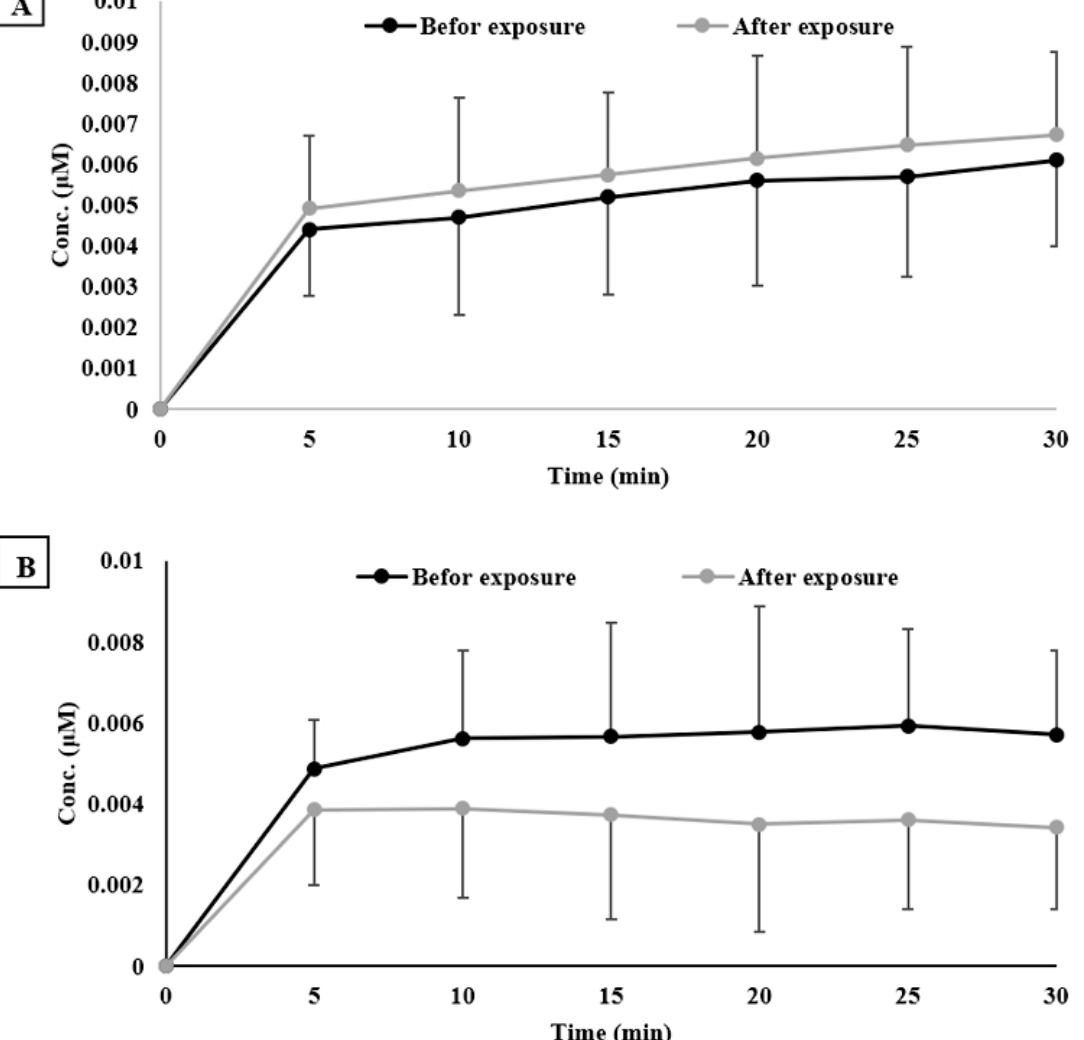
FIGURE 1 - Perfusate concentration-time profile of mean metabolic ratios before and after exposure of rats’ liver to 300 ng/ml (A) and 600 ng/ml (B) of MDMA (Ecstasy) following the passage of the perfusion buffer containing 2000 μM chlorzoxazone through the portal